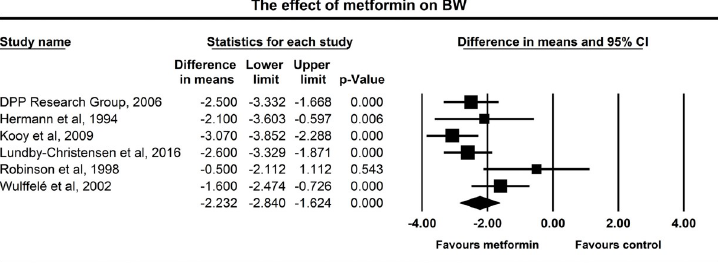
Fig 3. Forest plot analysis of body weight (BW) in participants treated with metformin compared with